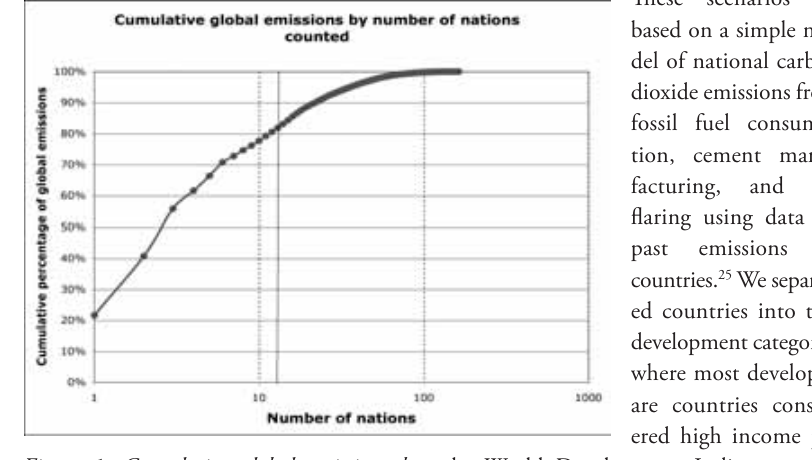
Figure 1: Cumulative global emissions by number of nations counted. Vertical line delineates the top thirteen global emitters, a group we refer to as the ‘Baker’s Dozen’. Note that the x-axis is presented on a log